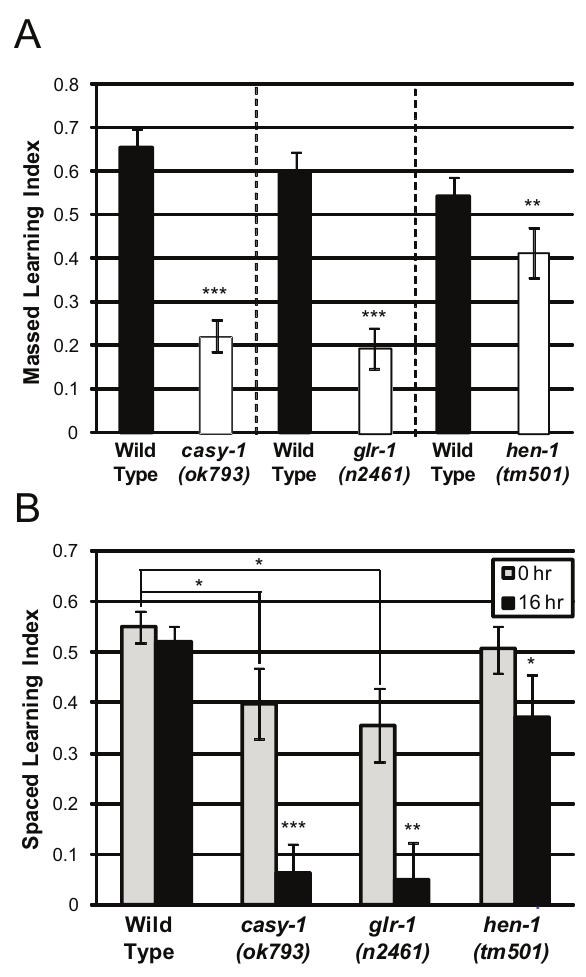
Figure 2. Known learning mutants perform poorly in learning and long-term memory assays. (A) casy-1(ok793) , glr-1(n2461) , and hen-1(tm501) mutants have significant learning defects after 1 6 massed training. (B) casy-1(ok739) and glr-1(n2461) mutants are defective for initial 0 h spaced learning and subsequent 16 h memory; hen-1(tm501) mutants are slightly defective for 16 h memory. (A–B): n $ 6 trials (Figure S1D); 6 SEM; * p , 0.05, ** p , 0.01, *** p , 0.001.